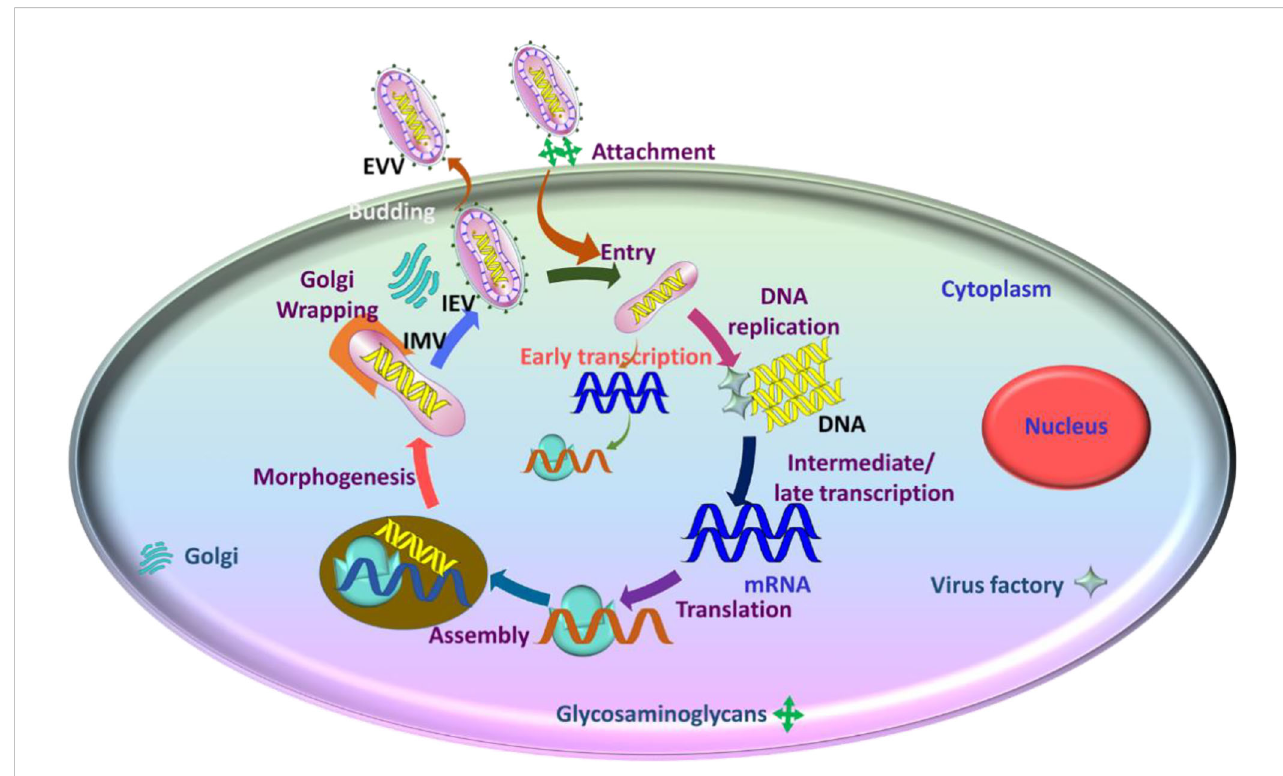
FIGURE 4 The steps involved in the replication of MPV and the generation of new viral